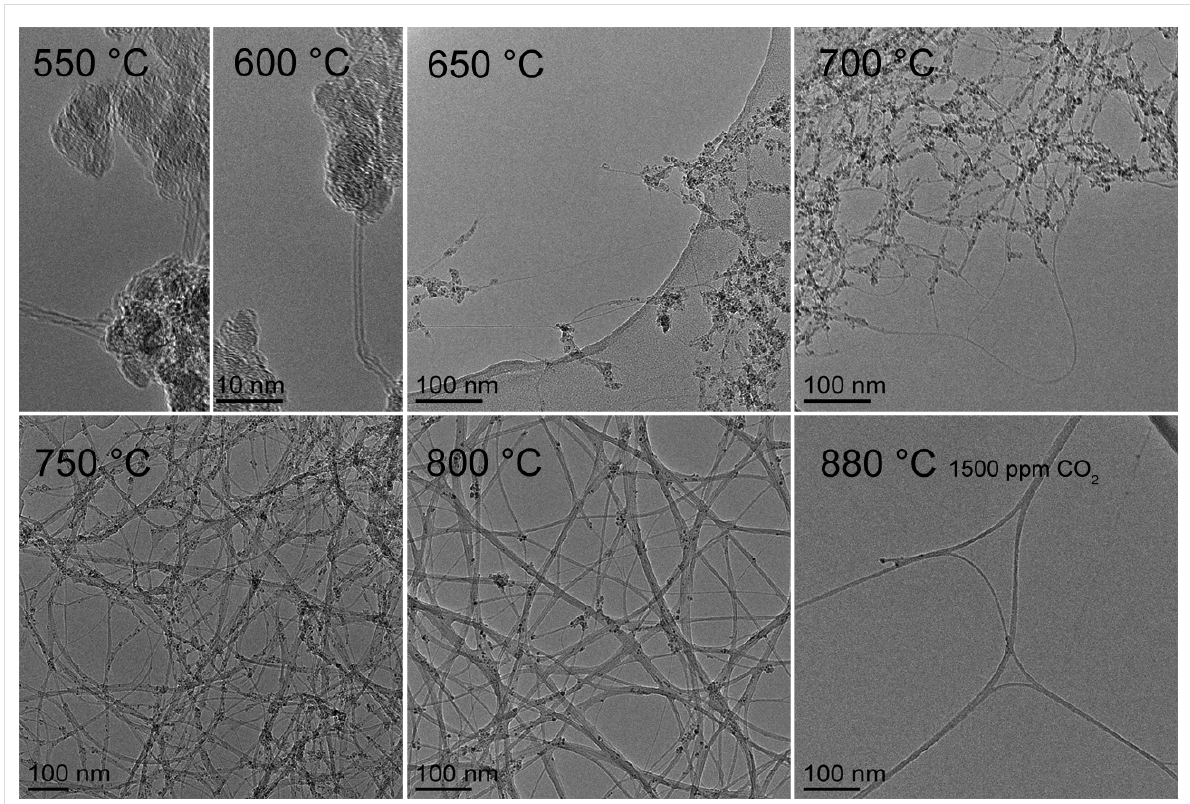
Figure 2: TEM micrographs of the as-produced SWCNTs. The synthesis conditions and corresponding bundle diameters are 550 °C, 1300 ppm, N/A; 600 °C, 1300 ppm, N/A; 650 °C, 1300 ppm, 3.1 ± 1.0 nm; 700 °C, 1300 ppm, 3.4 ± 1.0 nm; 750 °C, 1300 ppm, 3.2 ± 1.5 nm; 800 °C, 1300 ppm,